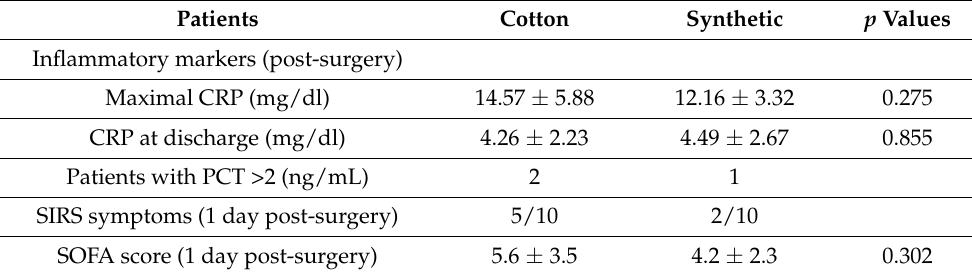
Table 2. Cont . Patients Cotton Synthetic p Values Inflammatory markers (post-surgery) Maximal CRP